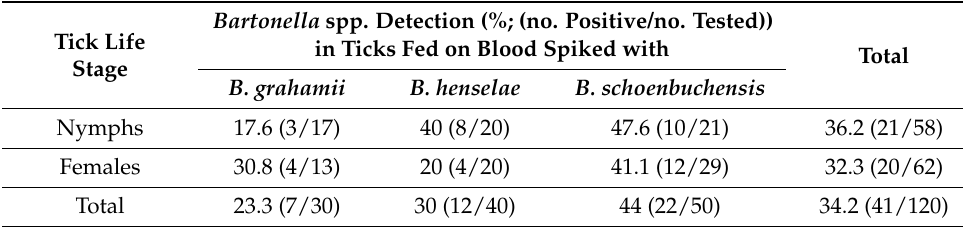
Table 3. PCR detection of Bartonella spp. transmission from the blood meal to feeding ticks. Bartonella spp. Detection (%; (no. Positive/no. Tested)) Tick Life in Ticks Fed on Blood Spiked with Total Stage B. grahamii